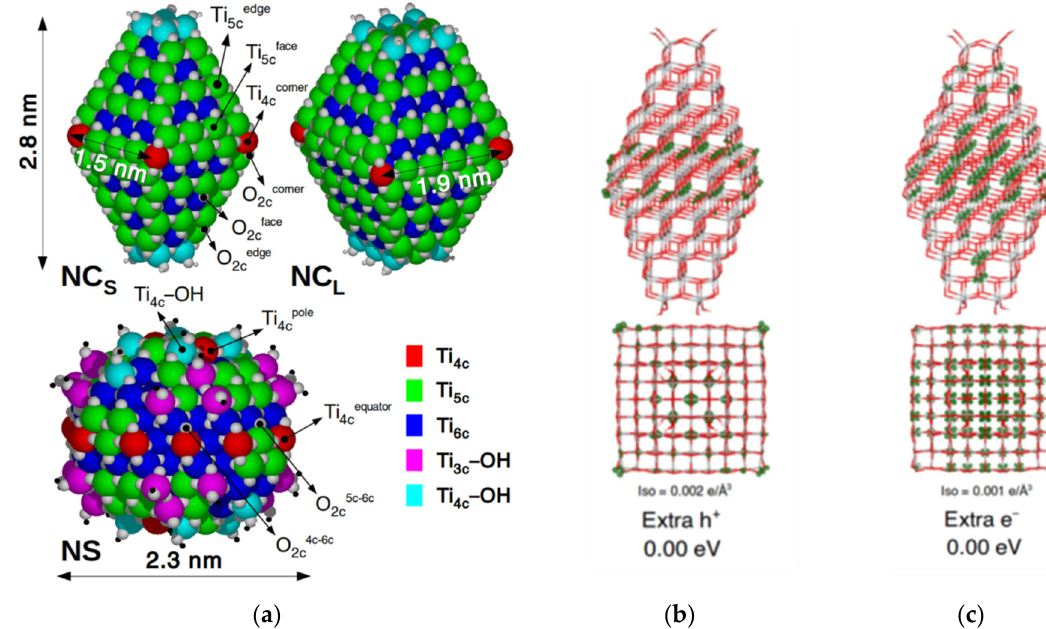
Figure 2. ( a ) The structure of the anatase nanoparticles NC S (TiO 2 ) 159 (H 2 O) 4 , NC L (TiO 2 ) 260 (H 2 O) 6 , and NS (TiO 2 ) 223 . ( b ) Spin density of an extra hole in the NC S nanoparticle. ( c ) Spin density of an extra electron in this nanoparticle. Reprinted with permission from Reference [13]; copyright (2016) Elsevier.